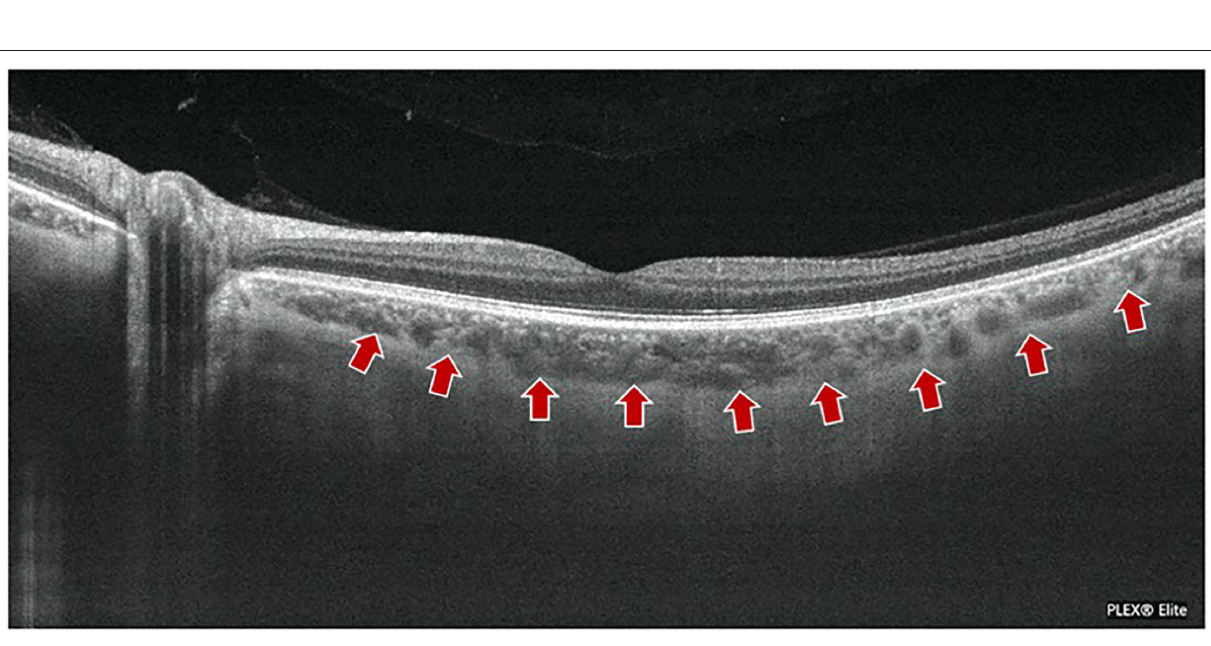
FIGURE 3 | A representative imaging of SS-OCT in normal subject. The boundary of choroid–scleral (arrows) and choroidal vasculature in a 49 year-old man are clearly shown using an SS-OCT (Plex Elite 9000, Carl Zeiss Meditec, Inc., Oberkochen, Germany). SS-OCT could reach up to 6mm depth, 200,000A scans per second (Plex Elite 9000) with 200,000A scans per second, and 6.3 µ m of axial